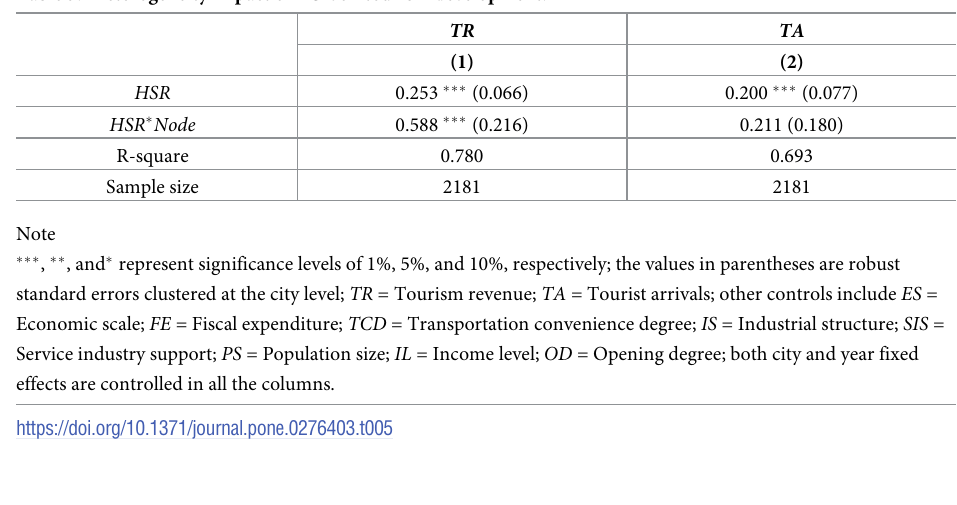
Table 5. Heterogeneity impact of HSR on tourism development.